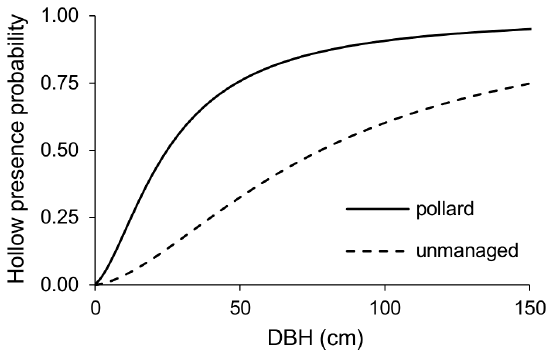
Figure 4. Predicted probability of hollow presence. Model predictions of hollow presence – probability that the tree with any given diameter (DBH) will contain a hollow, for pollards (solid line) and unmanaged willows (dashed line); (the x- axis is backtransformed to the original scale).